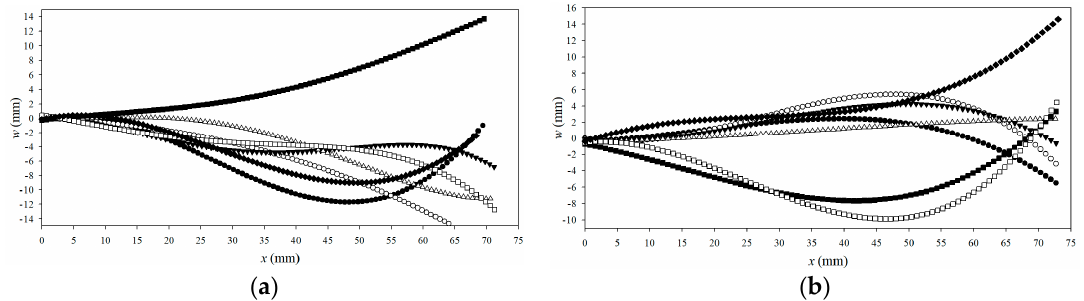
Figure 9. Characteristic deflected shapes t p = 100 µm, W = 10 mm, L = 75 mm RE = 14,279 ( a ) Water tunnel data; ( b ) FSI model results.